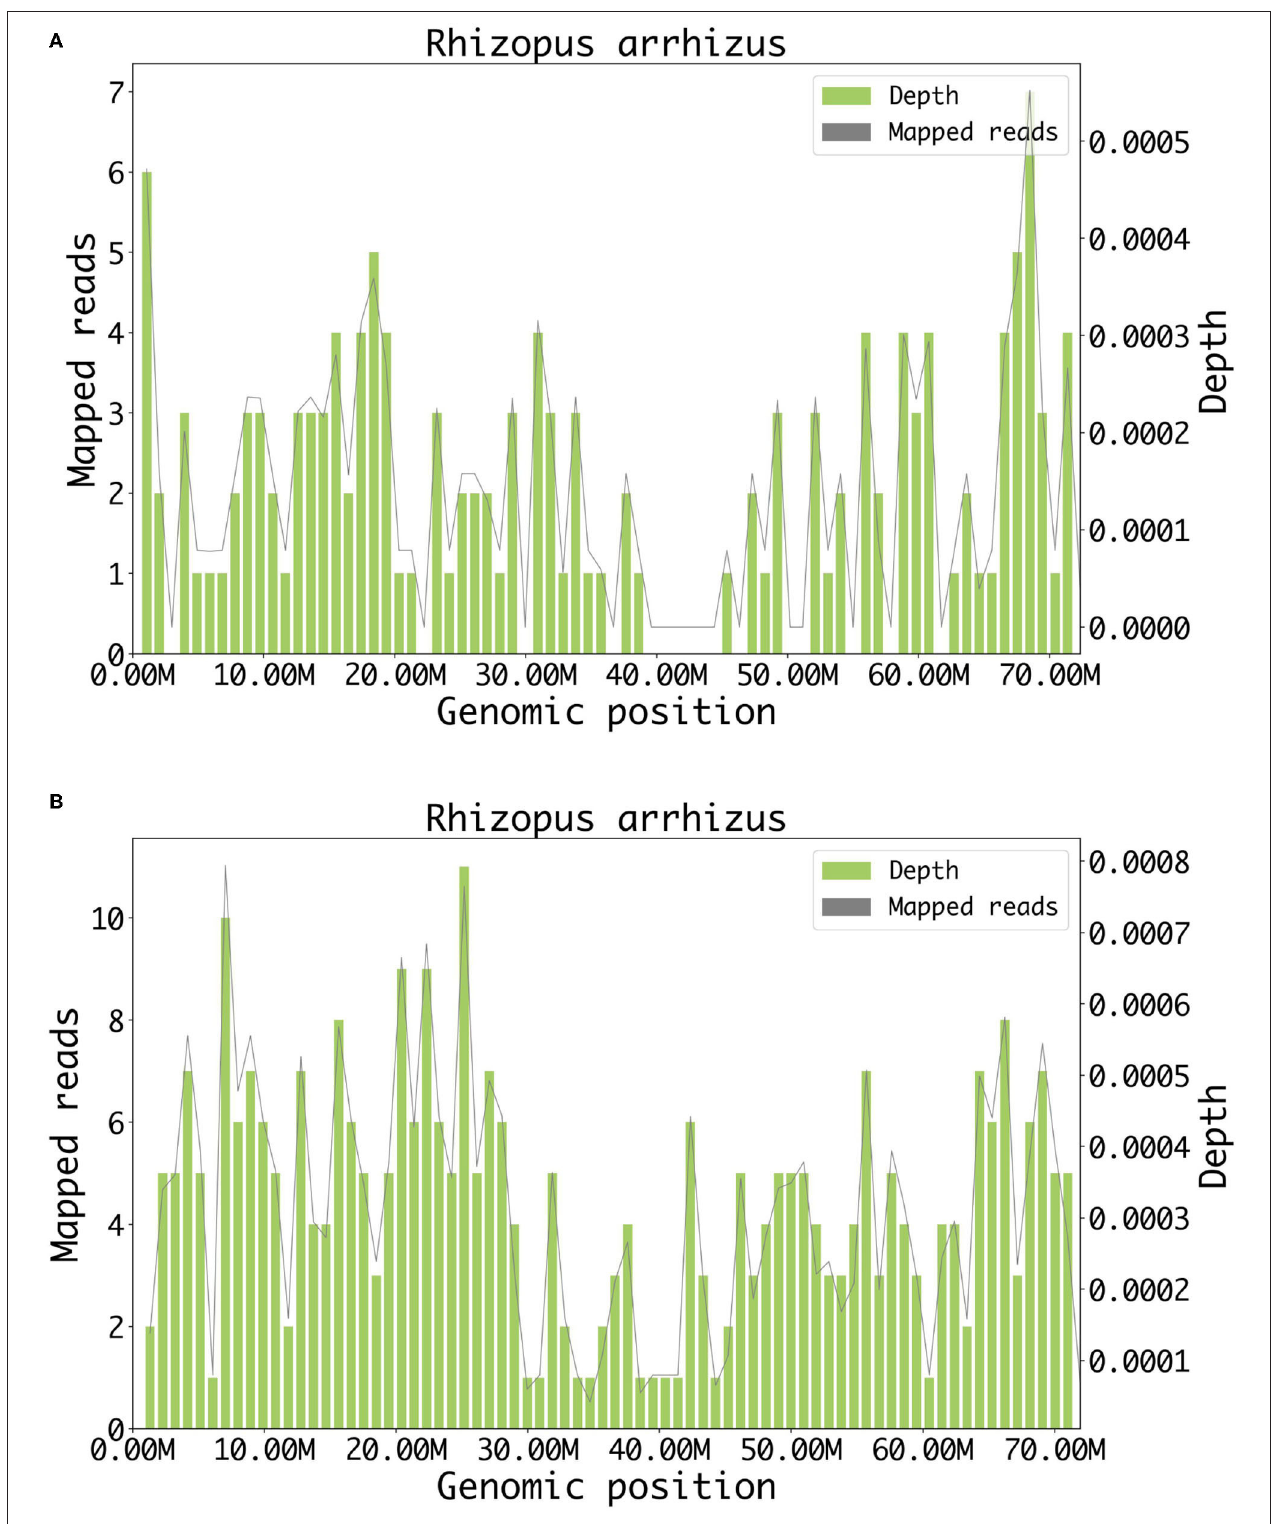
FIGURE 2 | Result of metagenomic NGS. (A) A total of 78 DNA reads mapped to Rhizopus arrhizus in cerebrospinal fluid. (B) A total of 131 DNA reads mapped to Rhizopus arrhizus in blood.